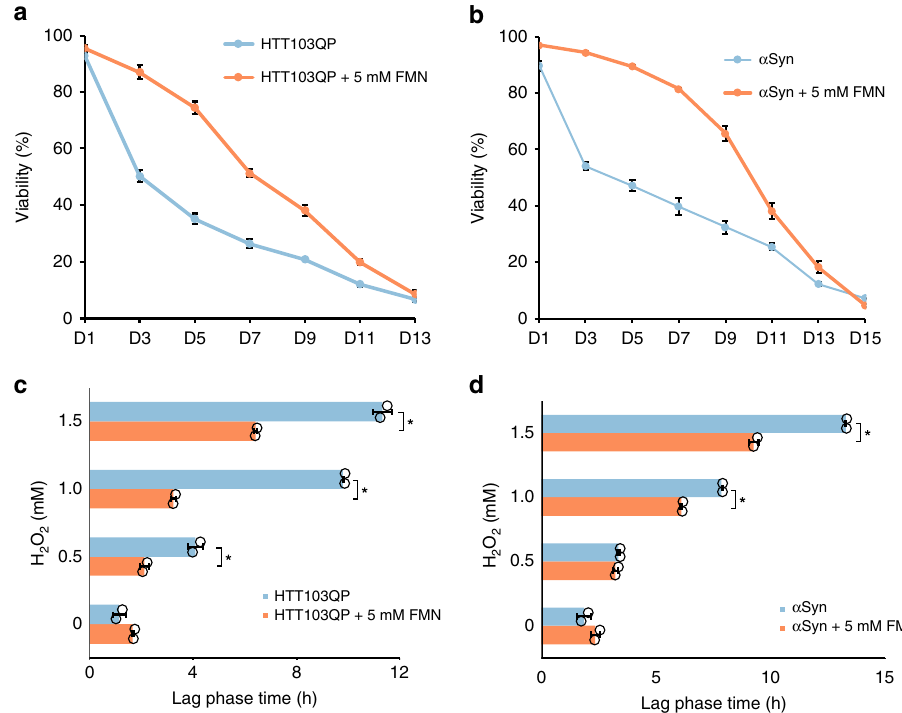
Fig. 7 FMN supplementation reduces HTT103QP and α -synuclein toxicity. Viability of the HTT103QP strain ( a ) and the α -synuclein strain ( b ) with 5 mM FMN supplemented during chronological aging. Viability is shown as the fraction of PI negative cells ( n = 3 ± SD). HTT103QP cells ( c ) and α -synuclein cells ( d ) display an increased H 2 O 2 tolerance with FMN supplementation. Cells without or with FMN supplement were grown to OD ≈ 0.2 and treated with different concentrations of H 2 O 2 . Cell growth was monitored using a microplate reader with lag phase time analyzed using the R package growthrates. Results shown are average values± SD of biological duplicates. The asterisk (*) indicates signi fi cant difference ( p < 0.05). Source data are provided as a Source Data fi